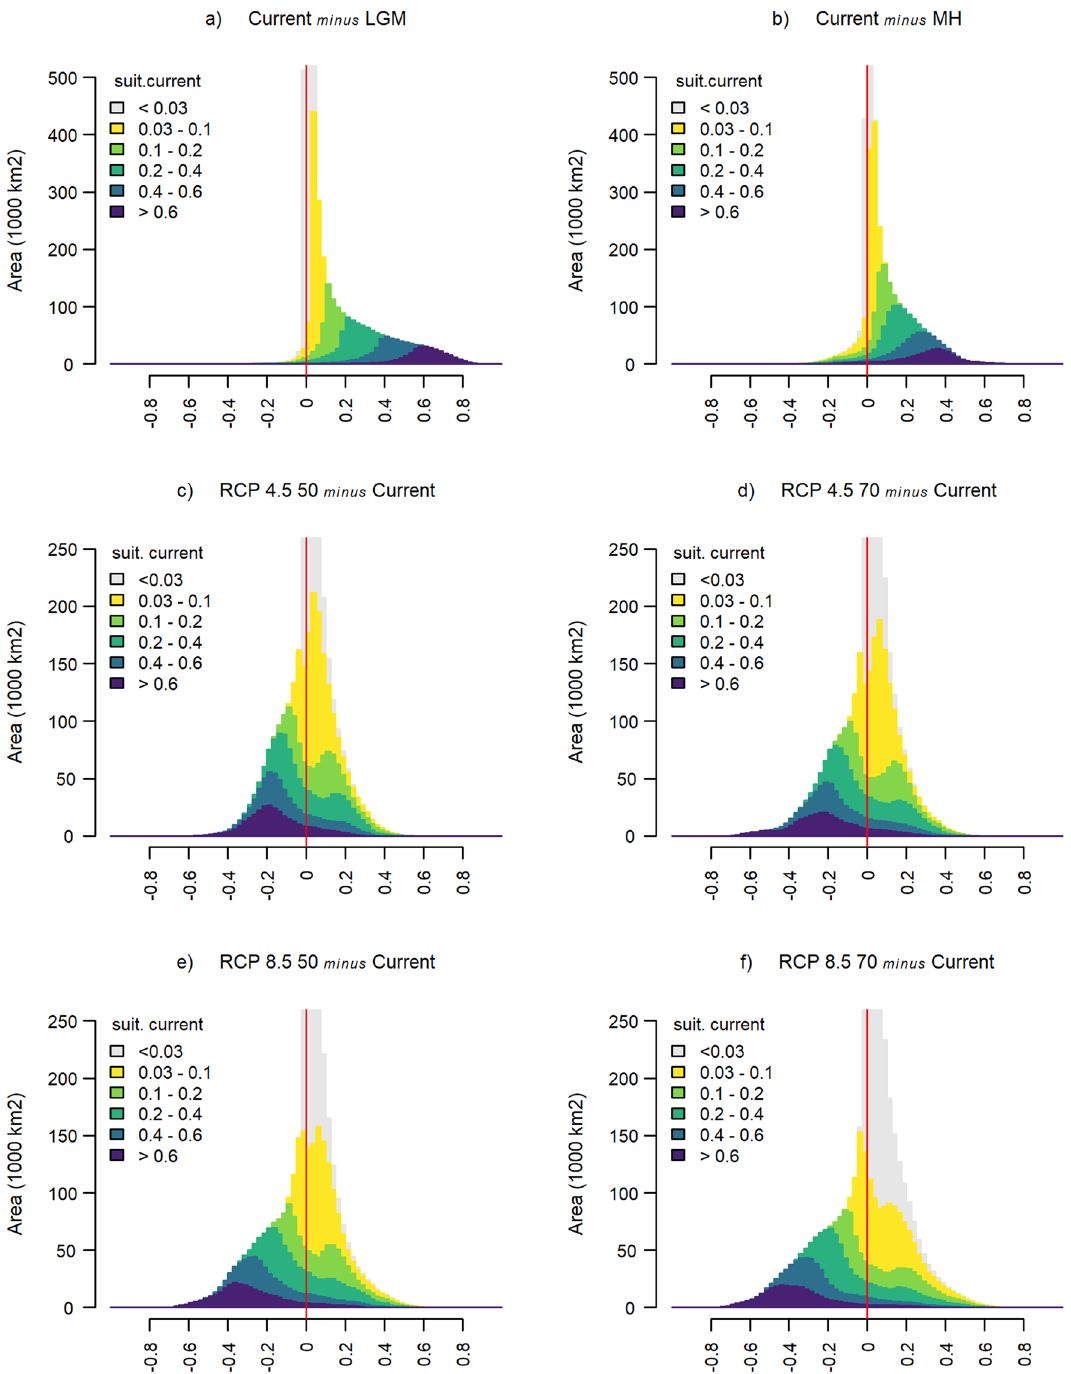
Figure 4. Differences between current and projected past and future scenarios suitability histograms. The x-axis is suitability current – suitability past for past scenarios and suitability future – suitability current for future scenarios. Each coloured band refers to a class of current suitability and its area in the histogram is proportional to the geographical area of the region with current suitability within this class. Areas with increasing/decreasing suitability (“expansion”/”contraction”) correspond to positive/negative differences and lies on the right/left hand side of the vertical red line. The area of each coloured band is the same across all histograms; the relation between the areas on each side of the vertical red line gives information about the extent of contraction relative to expansion in each projected